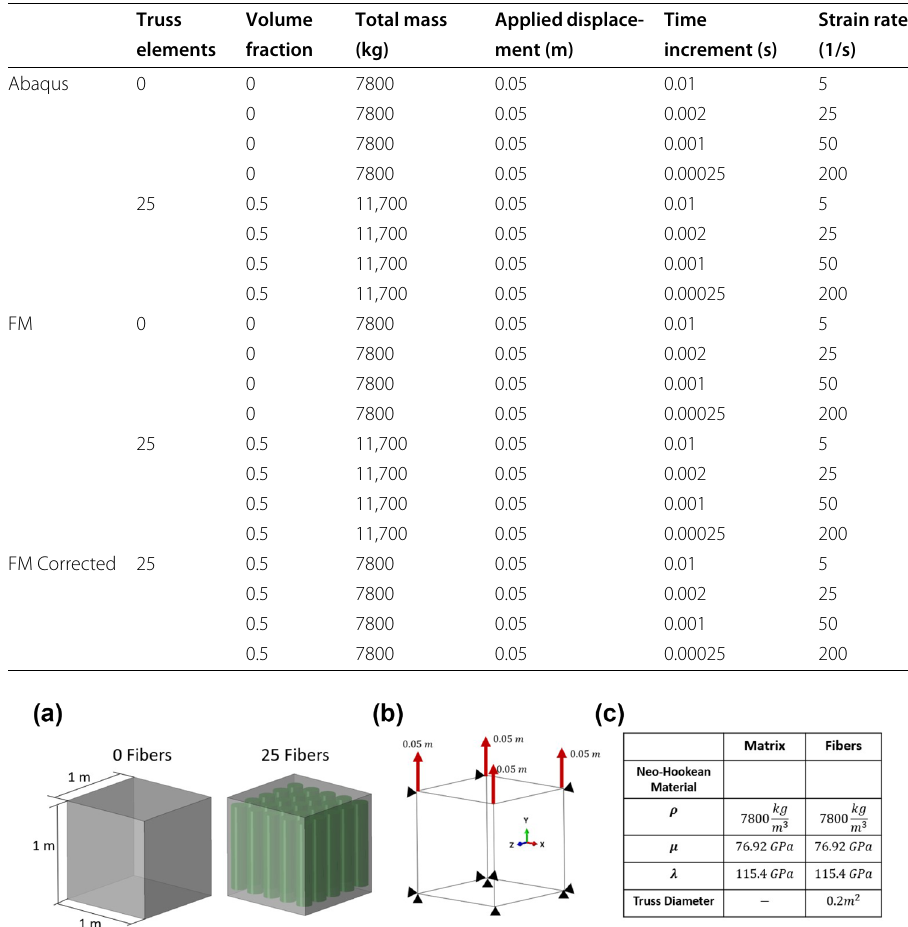
Fig. 12 Set up of the fiber volume fraction dependency tests, a images of 0, 2, 10, and 25 fiber meshes, b test boundary conditions, c matrix and fiber material properties Table 2 Strain rate dependency tests